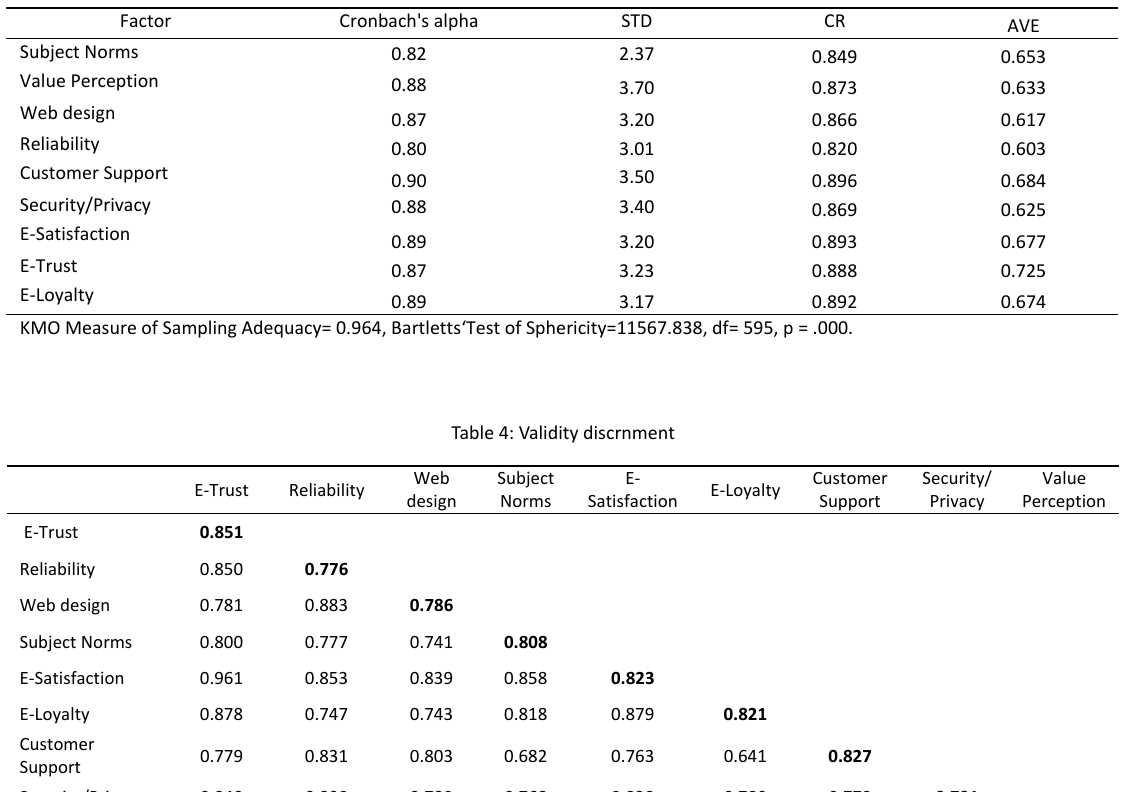
Table 3: Reliability of construct